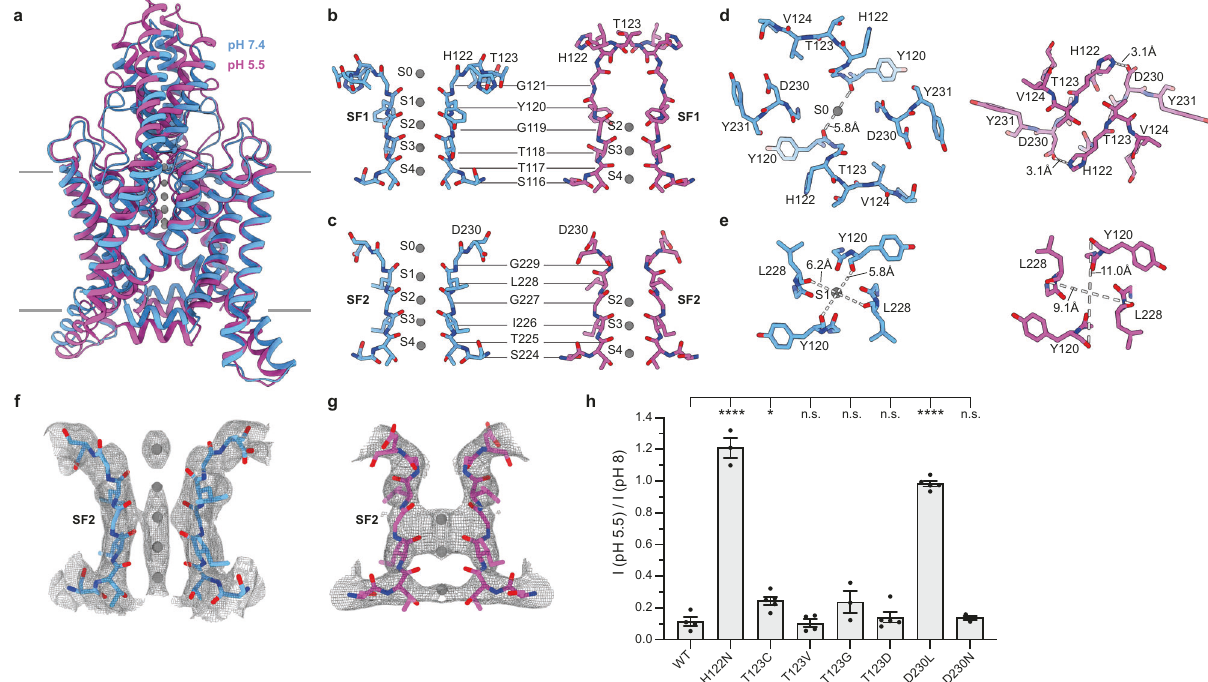
Fig. 3 TWIK1 selectivity fi lter gate controlled by pH ext . a Overlay of open (pH 7.4, blue) and closed (pH 5.5, magenta) conformations of TWIK1 viewed from the membrane plane. b – e Comparisons of regions involved in the selectivity fi lter gate from open (left) and closed (right) TWIK1 structures. b SF1, c SF2, d the top of the selectivity fi lter, and e coordination site S1 are shown b , c from the membrane plane and d , e from the extracellular side. K + coordination sites S0-S4 and intra-carbonyl or H122-D230 salt bridge distances are indicated. f , g Cryo-EM maps around the selectivity fi lter illustrating ion occupancy in f open and g closed structures. h Fraction of current remaining upon extracellular acidi fi cation (pH ext = 5.5/pH ext = 8.0 at 60 mV) for wild- type TWIK1 (0.11 ± 0.03) and mutants H122N (1.21 ± 0.06), T123C (0.24 ± 0.02), T123V (0.10 ± 0.02), T123G (0.24 ± 0.07), T123D (0.14 ± 0.03), D230L (0.98 ± 0.02), and D230N (0.14 ± 0.01). Mean plus s.e.m. were plotted for n = 4,3,5,4,3,5,5, and 3 cells, respectively. Differences were assessed with one- way analysis of variance (ANOVA) with Dunnett correction for multiple comparisons (* P = 0.0425; **** P < 0.0001; n.s. not signi fi cant). Source data for h are provided as a Source Data fi le.